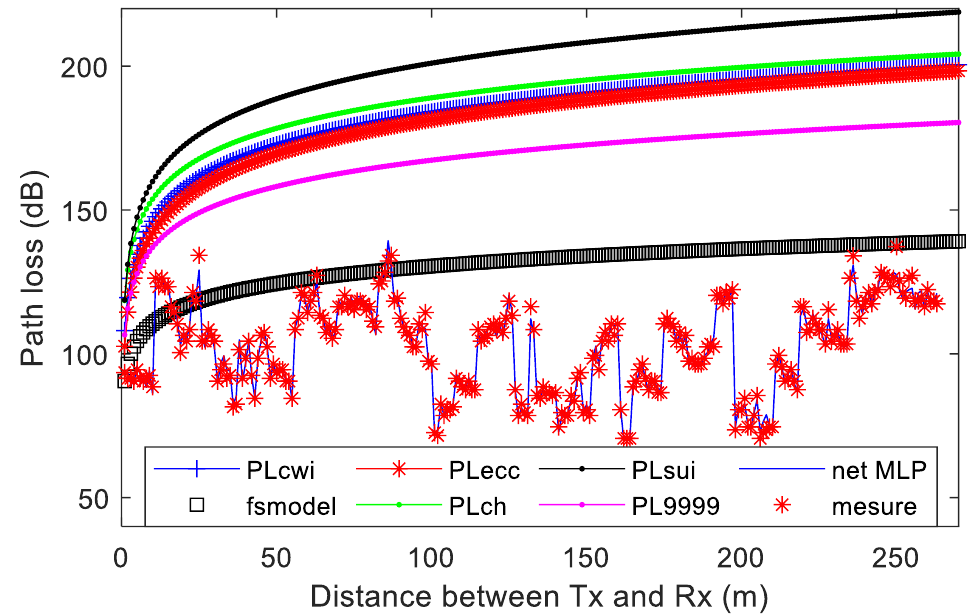
Figure 11. Comparison between empirical models and MLP (with one hidden layer) for Dataset 4.